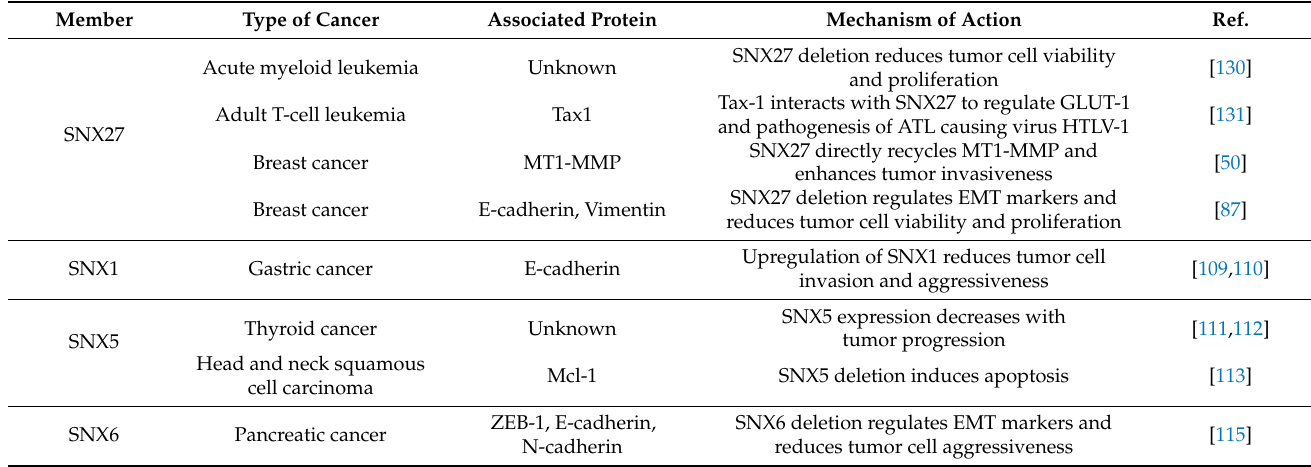
Table 4. Summary of SNXs reported in various